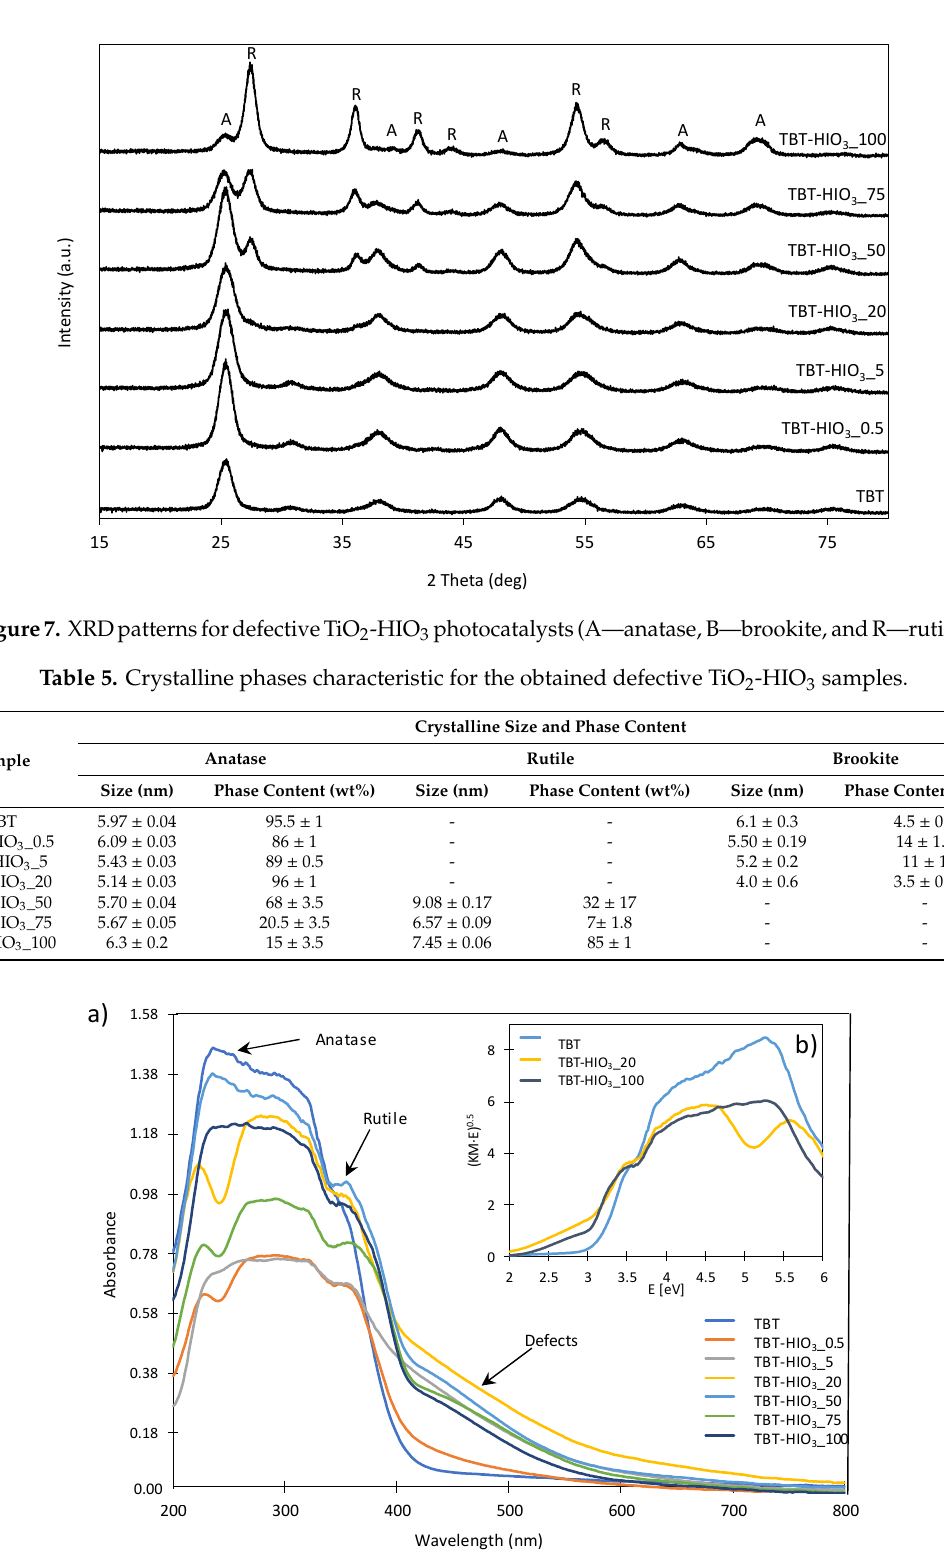
Figure 8. The diffuse reflectance (DR)/UV-Vis spectra for pure TiO 2 and defective TiO 2 -HIO 3 photocatalysts ( a ) together with exemplary Tauc transformation ( b ).